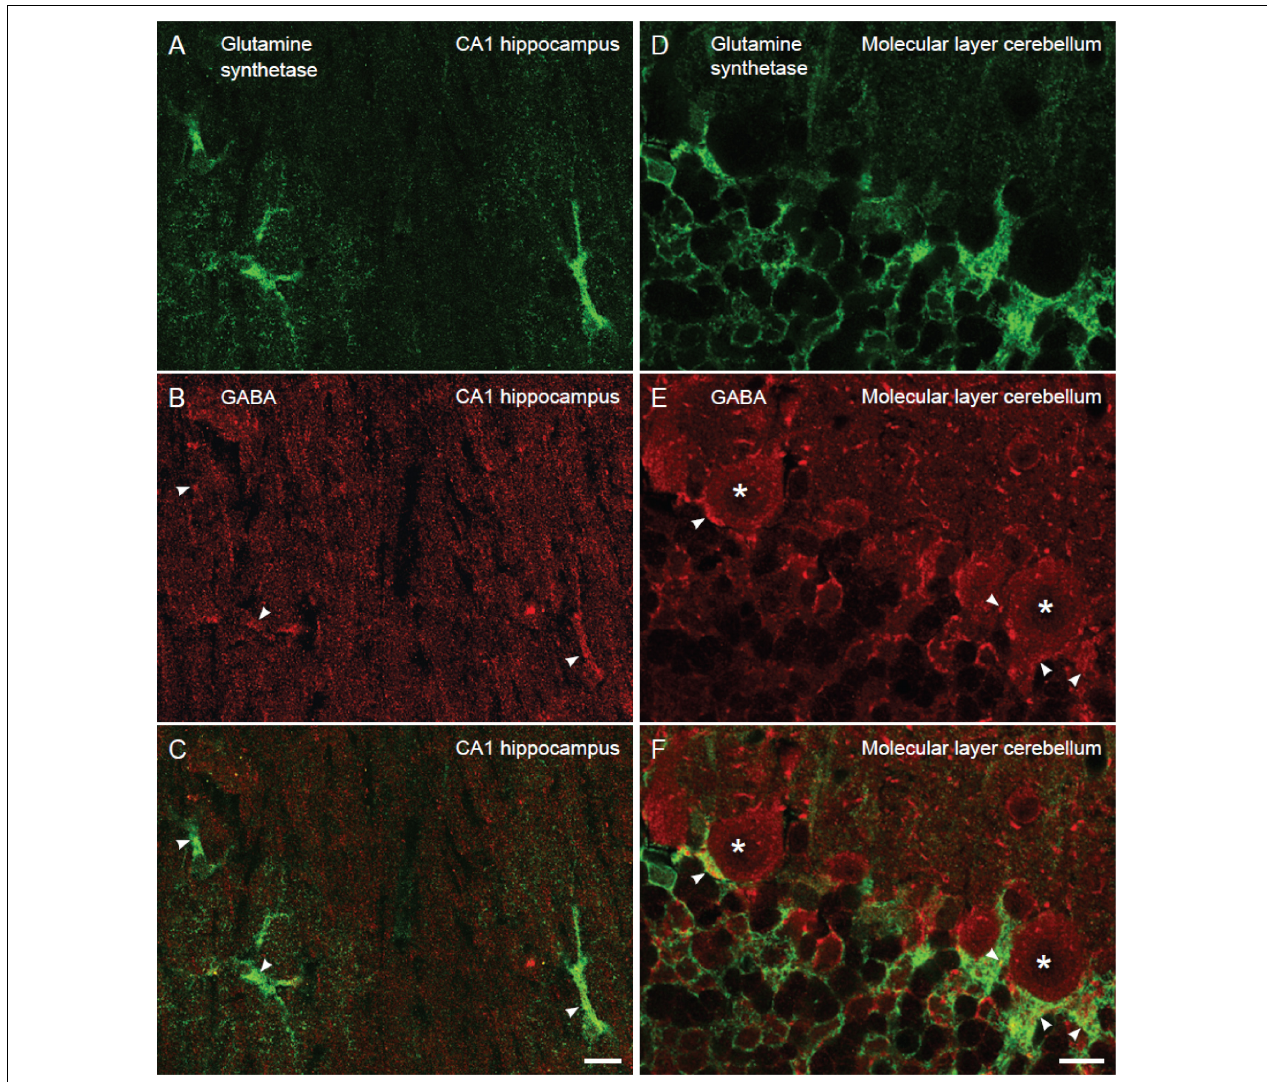
FIGURE 2 | The proportion of glutamine synthetase positive astroglia containing GABA immunoreactivity is similar in the hippocampus and the cerebellum. Confocal images of sections stained for GABA (red) and astroglia (glutamine synthetase, green). In the stratum radiatum of CA1 hippocampus (A–C) and the Purkinje cell layer of the cerebellum (D–F) there are GABA positive astroglia (arrowheads, yellowish in overlay in C,F ) at about the same number. Purkinje cells are stained for GABA (asterisk). 88% of the astrocytes contained GABA immunoreactivity in the CA1 stratum radiatum, and the value for Bergmann glia in the Purkinje cell layer of the cerebellum was 79% ( n = 28 GABA positive astrocytes of total 32 astrocytes and 30 GABA positive Bergman glia cells of total 39 Bergmann glia). To visualize GABA and glutamine synthetase labeling in the same section we used tissue fixed by 4% FA and 0.1% GA (higher GA concentrations produce autofluorescence that disturb analysis of co-labeling), making the GABA fluorescent signal somewhat weak. We observed that the GABA staining resided within glutamine synthetase positive astroglia in z-stacks, containing slices of 0.4 µ m thickness, which could be followed through astroglial cell bodies/larger processes (diameter > 2 µ m). Scale bars, 10 µ